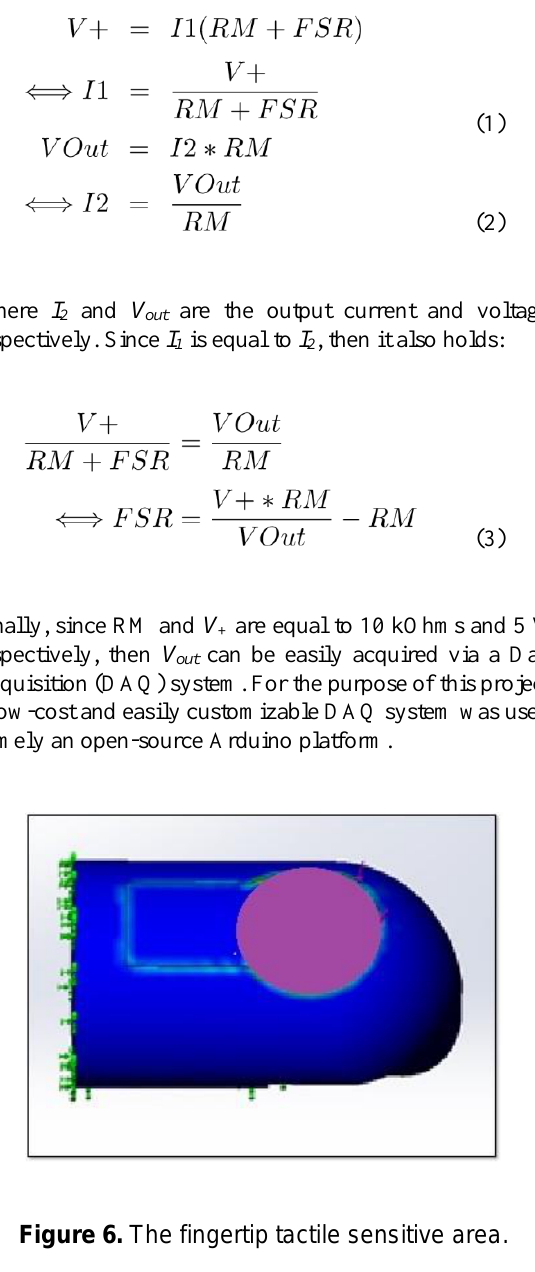
Figure 6. The fingertip tactile sensitive